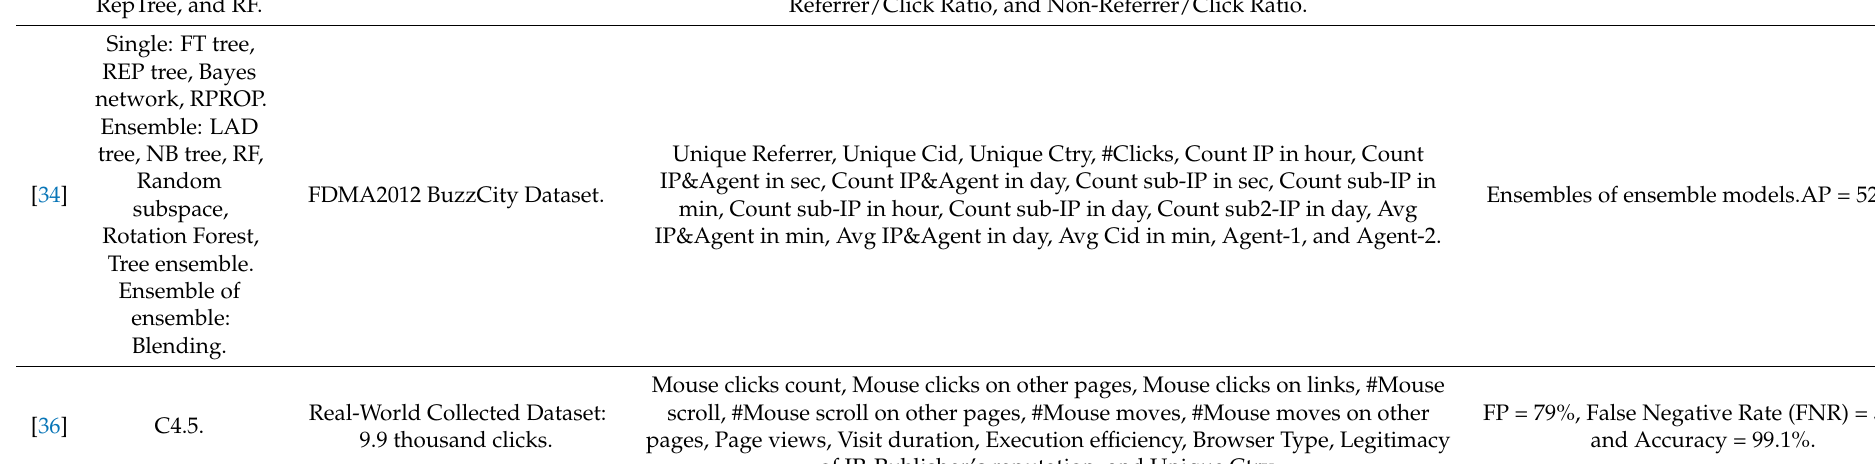
Referrer/Click Ratio, and Non-Referrer/Click Ratio.